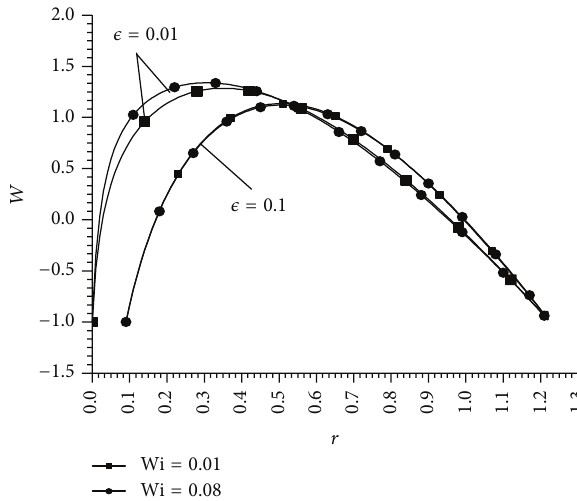
Figure 3: The velocity distribution 𝑤 , across the annulus with different values of 𝜖 and Wi at Re = 3 , 𝛿 = 0.1 , 𝑄 = 1.5 , 𝜙 = 0.4 , and ] 𝑧 = 0.1 , where 𝑟 ∈ [𝜖,𝑟 2